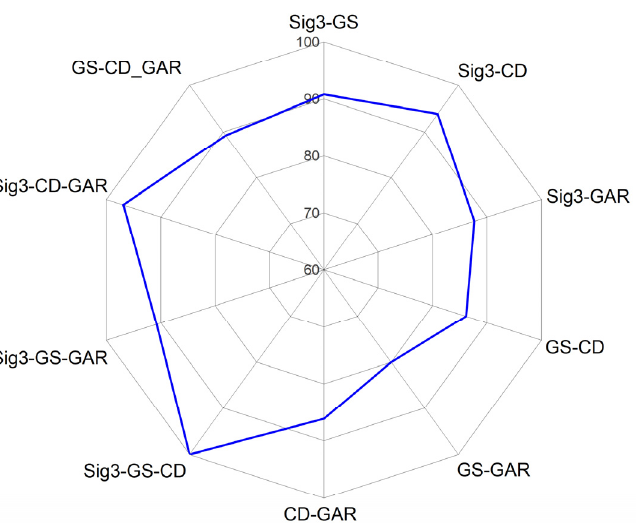
Figure 10. Discriminant accuracy according to the combination of the four discriminant factors.